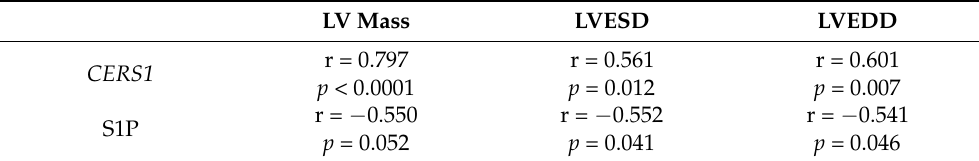
Table 2. Relationships between mRNA expressions of sphingolipid metabolism genes, sphin- golipid levels, and ventricular parameters in heart failure patients. LV Mass LVESD LVEDD r = 0.797 CERS1